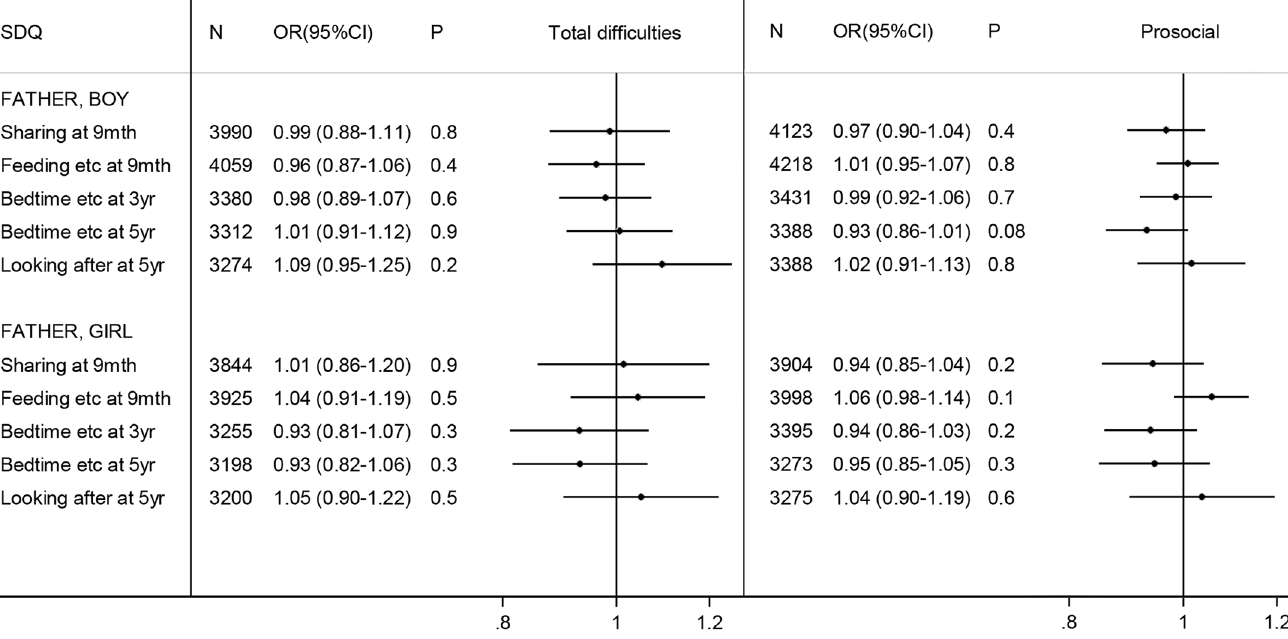
Fig 3. Adjusted odds ratio for child behaviour problems per quintile a of involvement: father-only measures. See Table 3 for adjustment factors. Involvement at 9 months, 3 years, 5 years (see Table 2 for details). Behaviour problems respectively at 3, 5, 7 years, i.e. SDQ score in the top decile for the total difficulties scale, bottom decile for the prosocial scale. a per quartile for ‘ Sharing at 9mth ’